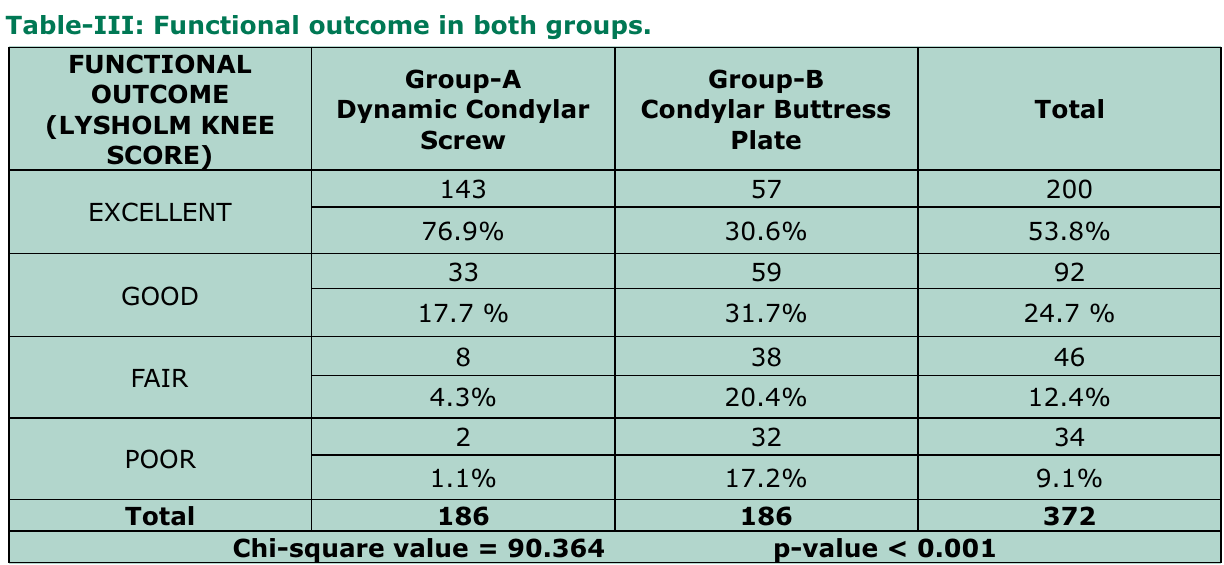
Table-III: Functional outcome in both